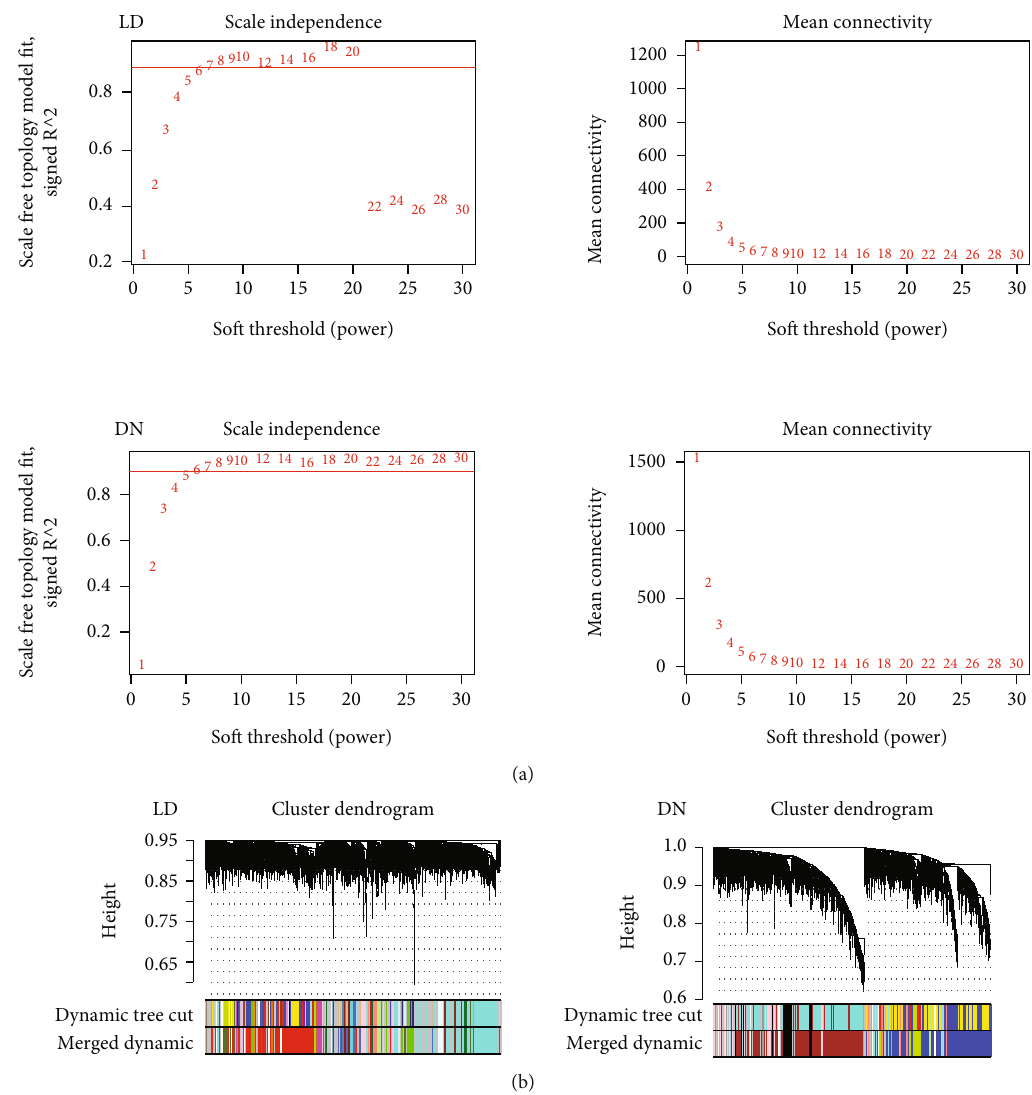
Figure 1: Gene modules in WGCNA analysis. (a) The soft power selection result of the DN and LD groups. (b) Module assignment in hierarchical clustered genes in the DN and LD groups. Genes within di ff erent modules are labeled with di ff erent colors according to WGCNA ’ s conventions. DN: diabetic nephropathy; LD: living donors; WGCNA: weighted gene coexpression network